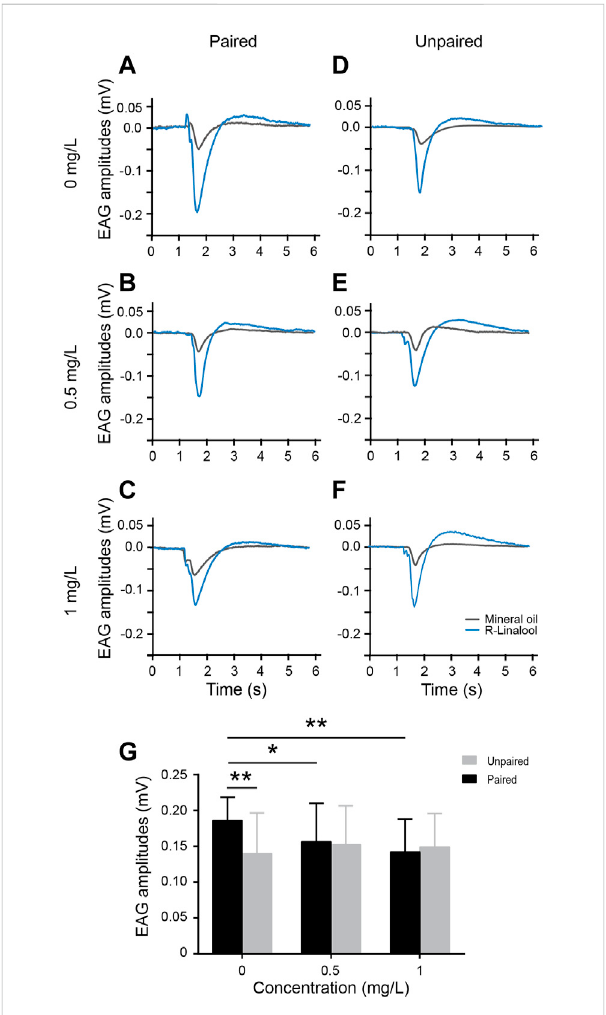
acquisition training. (A – F) Example EAG response waves of antennae from the paired and unpaired groups (average of three replicates), using mineral oil as a negative odor control (gray curves). (G) Average EAG peak amplitudes in the paired and unpaired groups